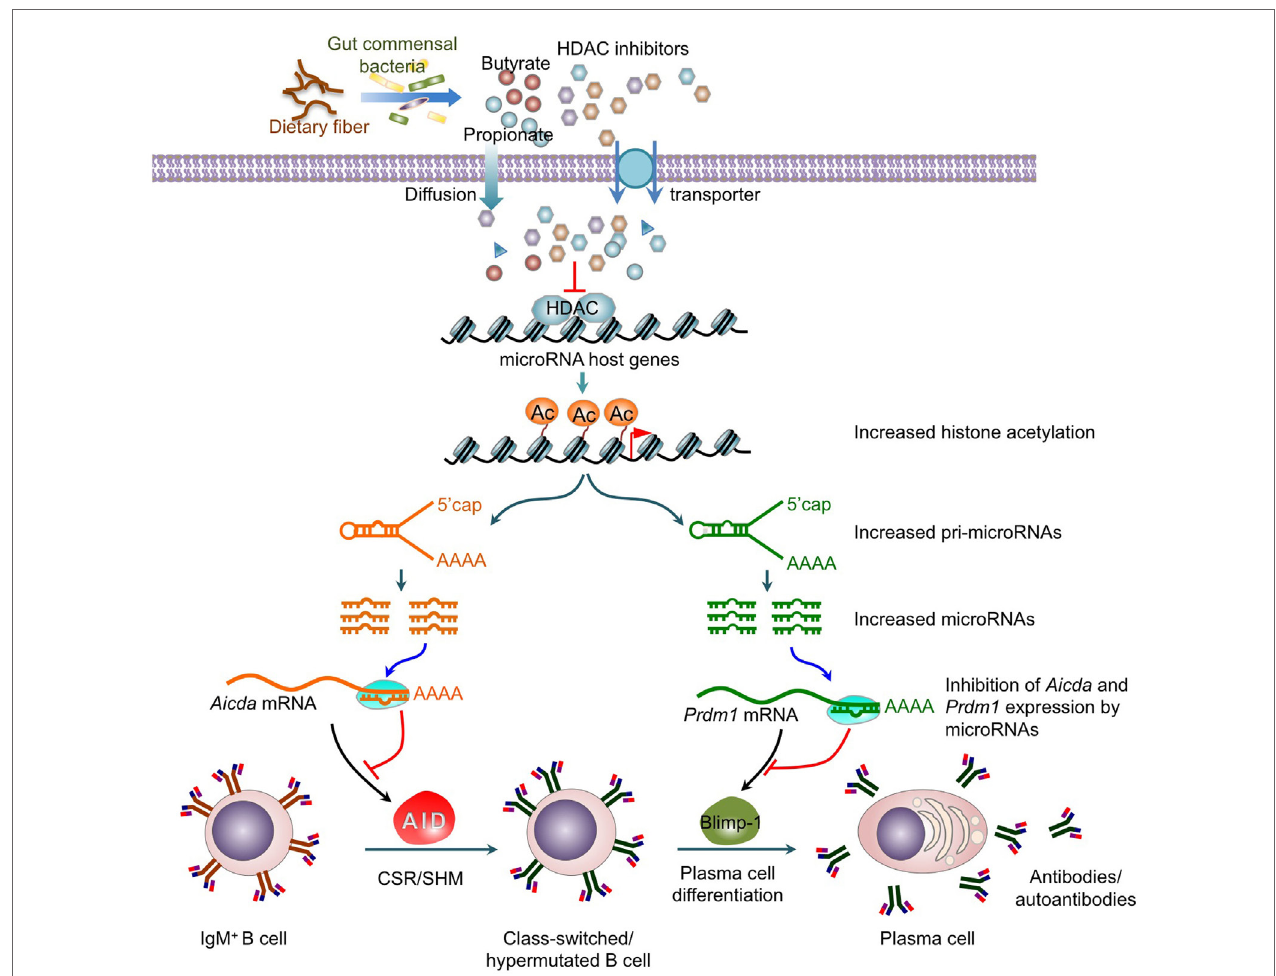
FiGURe 2 | Histone deacetylase inhibitors upregulate selected B cell miRNAs that silence AiD and Blimp-1 expression to epigenetically modulate CSR, SHM, plasma cell differentiation and antibody/autoantibody responses . HDAC inhibitors, including short-chain fatty acid butyrate and propionate produced by gut commensal bacteria through fermentation of dietary fiber, epigenetically modify CSR and SHM by upregulating miRNAs, which silence AICDA/ Aicda mRNA and PRDM1/Prdm1 mRNA. The upregulation of miRNA expression results from an increase in the histone acetylation of the host genes of these miRNAs. This leads to down-regulation of AID and Blimp-1 expression, and the dampening of CSR, SHM, and plasma cell